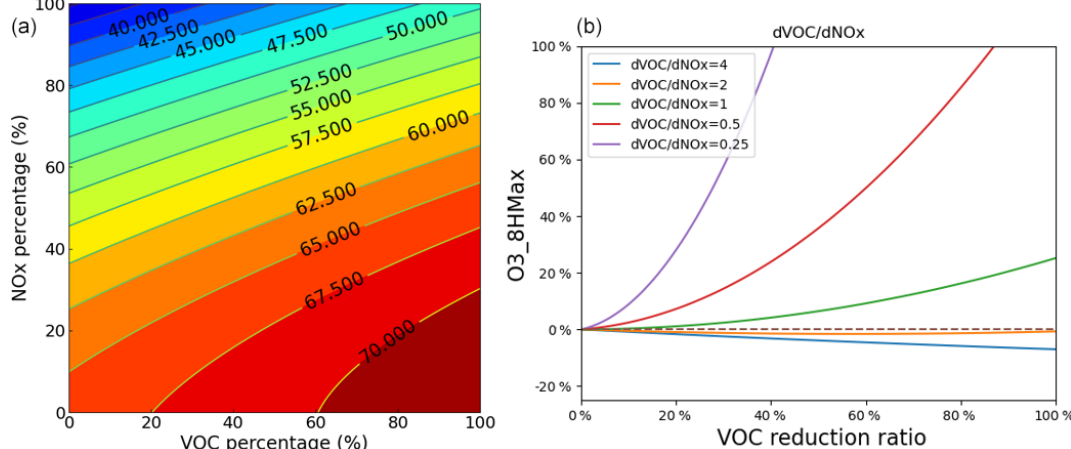
Figure 10. An O 3 isopleth diagram versus NO x and VOCs using EKMA (a) and a variation chart of O 3 concentration in each control path (b) during the pre-NMG period in